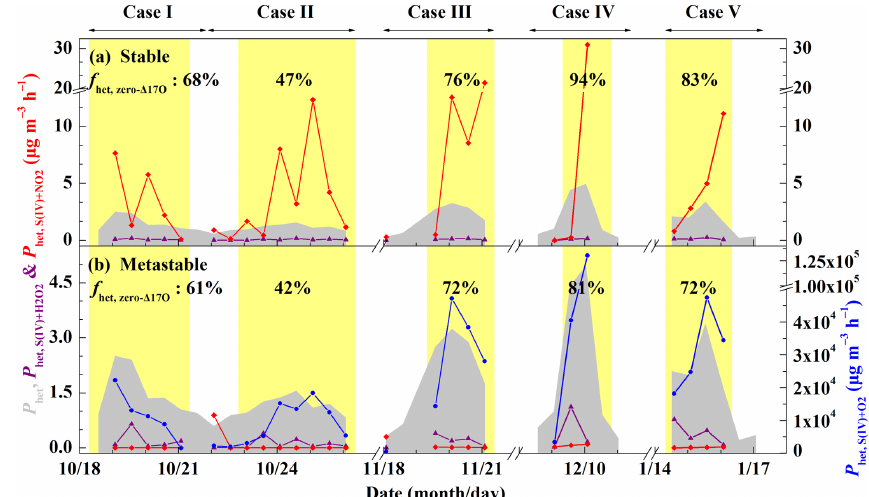
Figure 7. Estimate of heterogeneous sulfate production pathways. Time series of overall heterogeneous sulfate production rate ( P het ) and heterogeneous sulfate production rate in aerosol water via H 2 O 2 ( P het , S ( IV ) + H ) and NO 2 ( P het , S ( IV ) + NO ) under stable (a) and 2 O 2 2 metastable (b) aerosol assumption. P het , S ( IV ) + O in (b) represents heterogeneous sulfate production rate via SO 2 oxidation by O 2 via 2 a radical chain mechanism on acidic microdroplets. f represents the fraction of heterogeneous reactions that result in sulfate het , zero − (cid:49) 17 O with zero- (cid:49) 17 O, such as S(IV) oxidation by NO 2 and O 2 , to the overall heterogeneous sulfate production during PDs of each case with the constraint of (cid:49) 17 O(SO 2 − ) (see the main text for details). In calculating P het , S ( IV ) + H , the influence of I s was considered. In calculating 4 2 O 2 P het , S ( IV ) + NO and P het , S ( IV ) + O the influence of I s was not considered due to the lack of experimental data about the influence of I s . 2 2 P het , S ( IV ) + O was calculated using the aqueous-phase rate constant for pH ≤ 3 due to the lack of rate constant information at pH > 3. The 2 light yellow shaded area indicates polluted days (PDs, PM 2 . 5 ≥ 75µgm − 3 ). Data used here are 12-hourly averaged values, corresponding with filter samples.